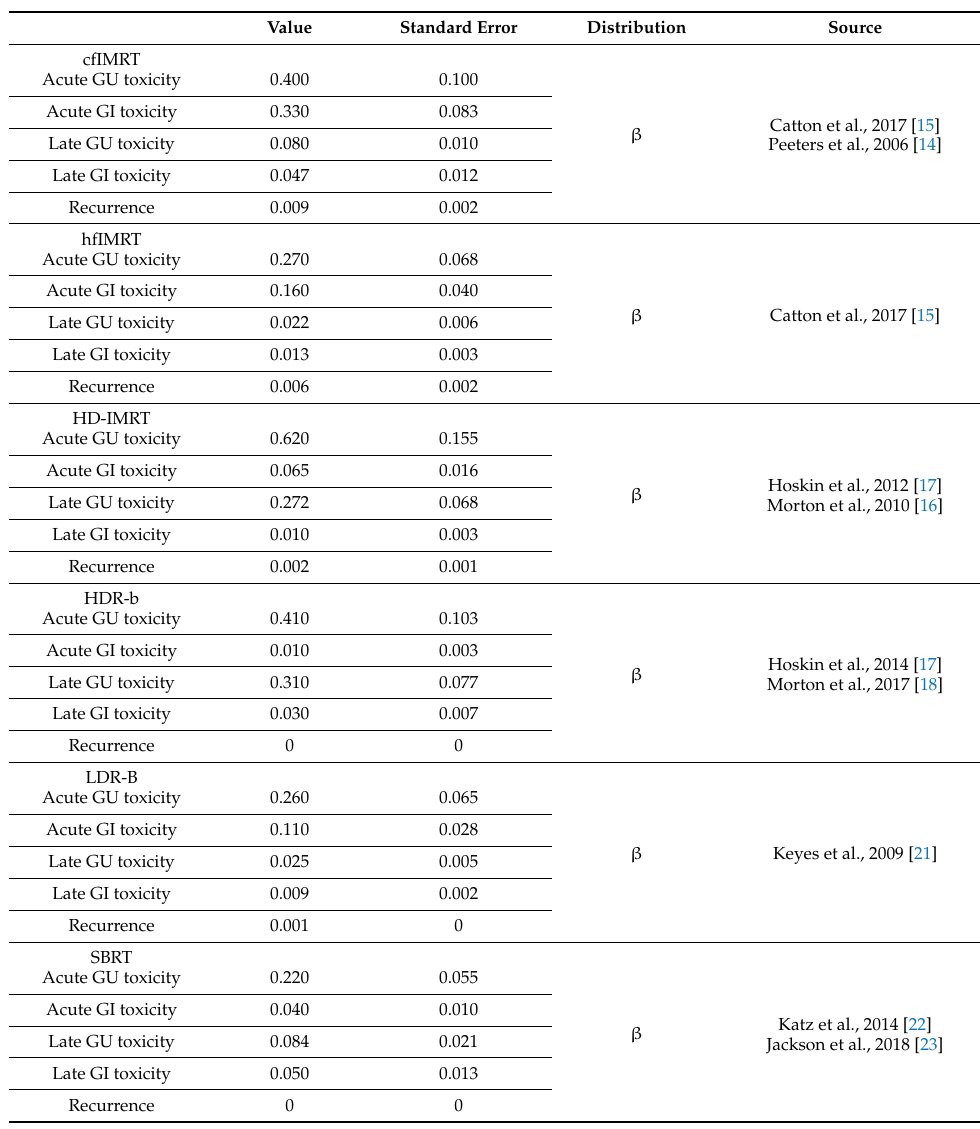
Table A1. Transition probabilities.